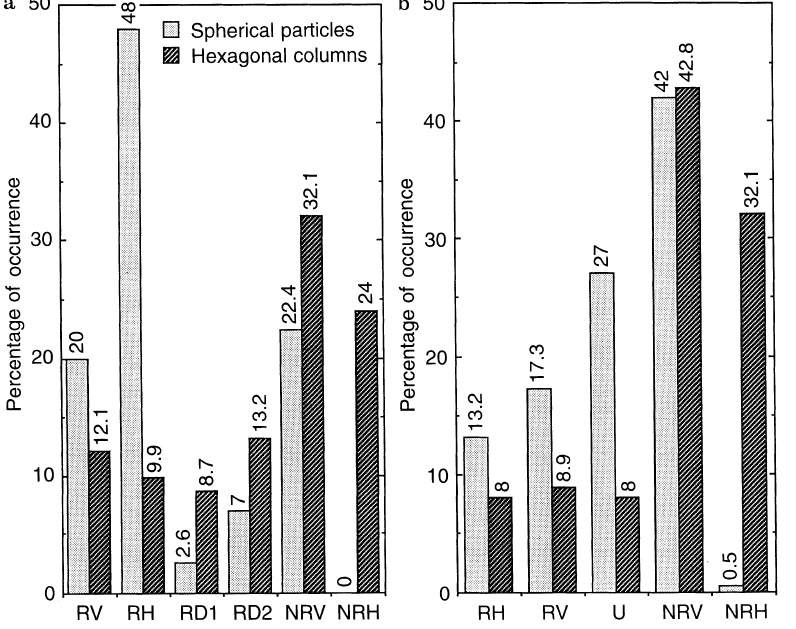
Fig. 3a,b. Configuration of a 2-pixels and b 3- pixels obtained with the model